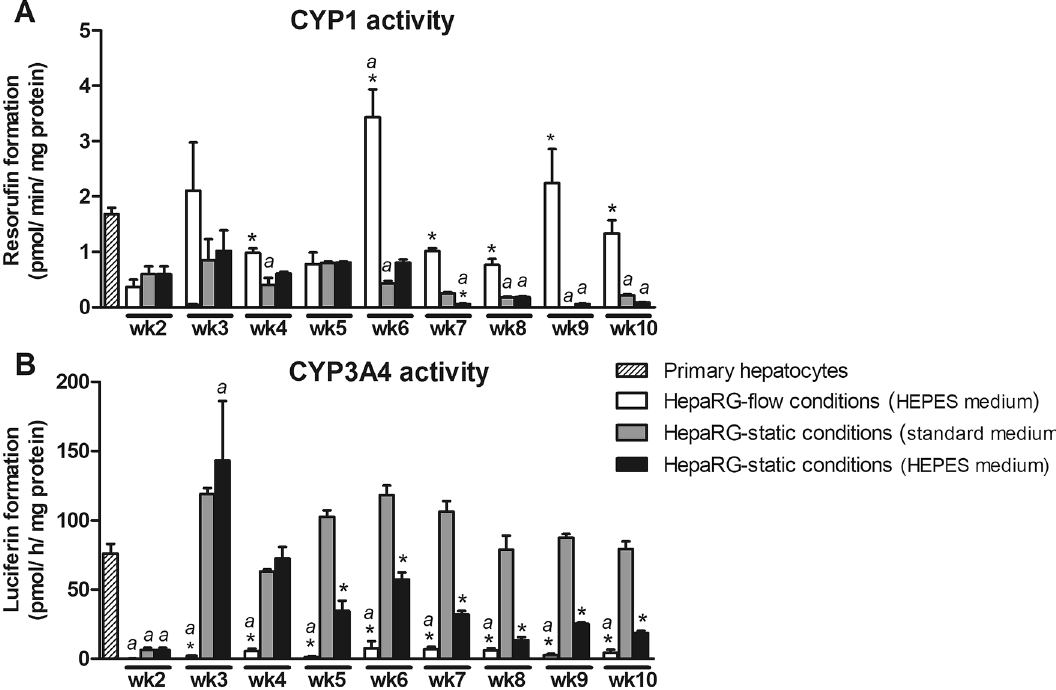
Figure 4. Baseline CYP1 ( A ) and CYP3A4 ( B ) activity in HepaRG cells cultured under flow (OOC device) and static conditions (96-well plates) from week 2 to 10, and in human primary hepatocytes (mean ± SEM; n = 3–6). a Significantly different from primary hepatocytes. *Significantly different from HepaRG static culture with standard medium (comparison within the same week, not assessed for primary hepatocytes). One-way ANOVA and Bonferroni post-hoc tests were used for statistical analyses ( P < 0.05). Activity was normalized to cell density using protein content data as measured in the cell lysate from the corresponding well/OOC-device. Results of normalization based on DNA content gave similar outcomes (see Suppl. Figure